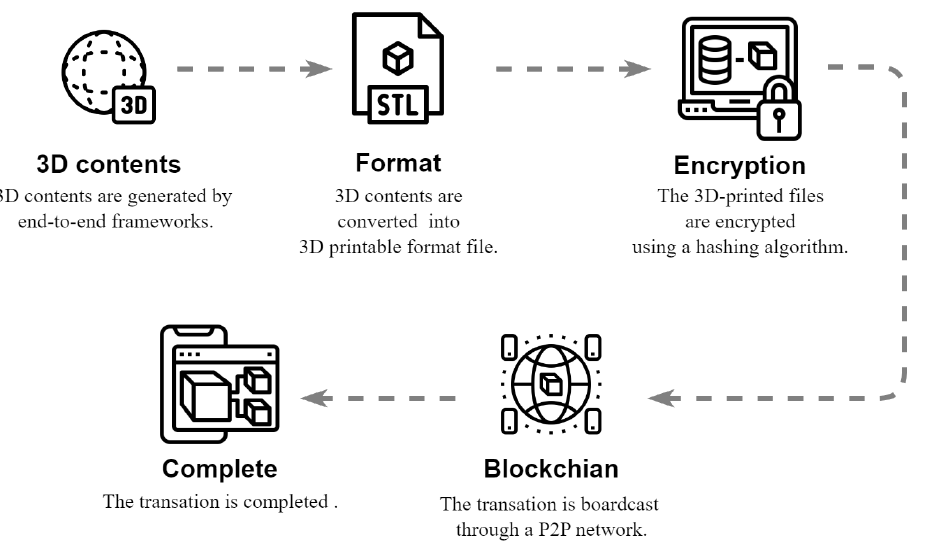
Figure 5. Process of blockchain encryption of 3D